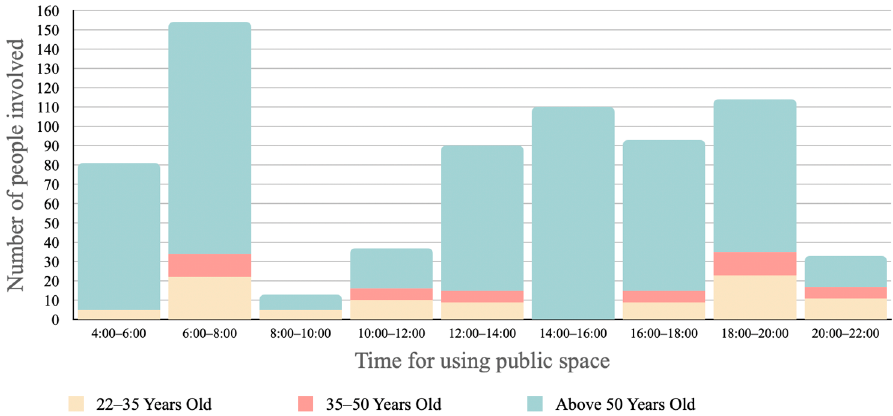
Figure 8. Time slots for different age groups in the use of public spaces.